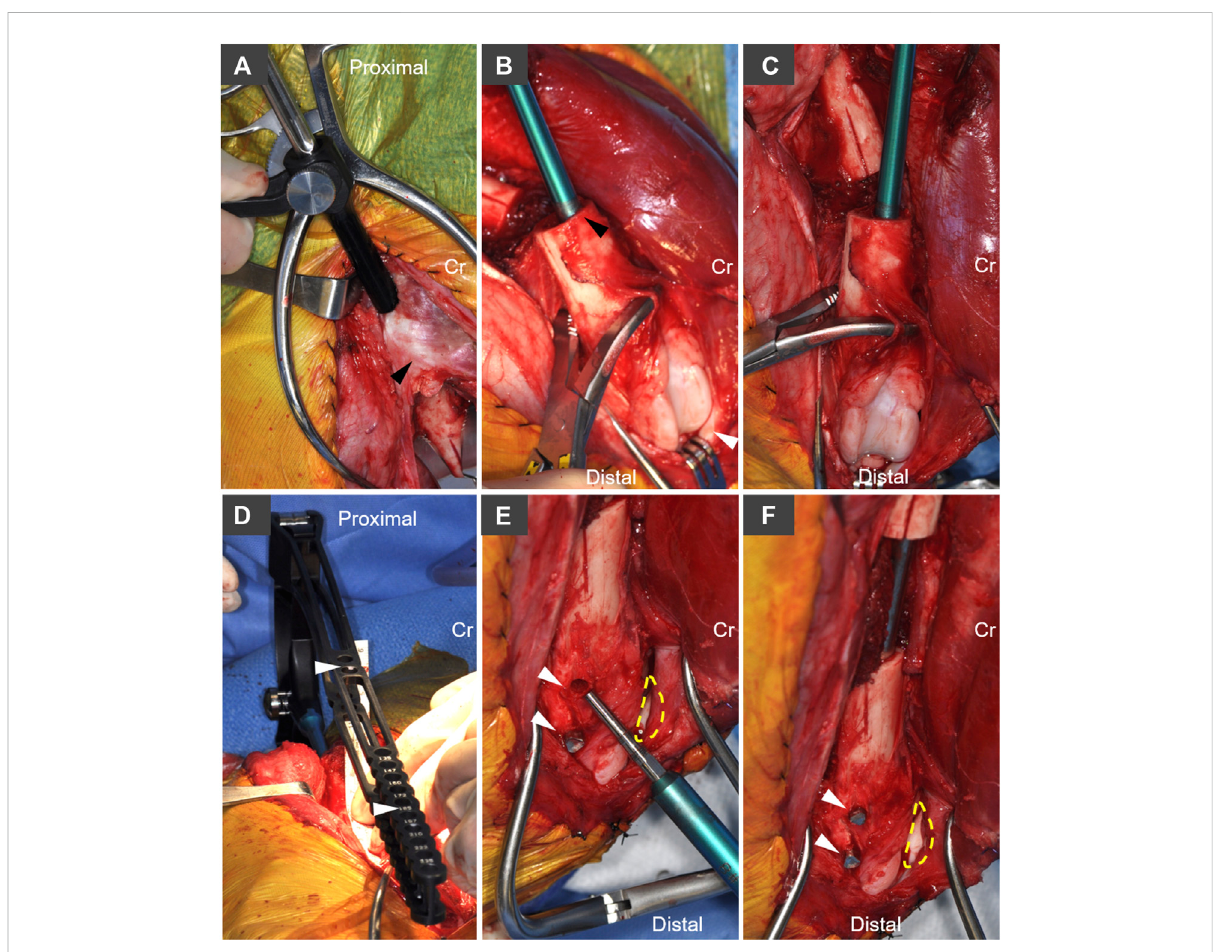
FIGURE 2 Implantation technique andsystem-speci fi cinstrumentationfortheAS-ILN. (A) Theintertrochanteric fossa wasidenti fi edandopened witha1/ 8 inch (3.2 mm) intramedullary pin. Following pin removal, a system-speci fi c cutting tool and tissue protector were used to enlarge this opening to 8 mm. Cr denotes cranial, arrowhead denotes base of the greater trochanter. (B) The distal femur was stabilized with bone holding forceps placed proximal to the trochlea. A system speci fi c cutting tool (8 mm diameter) was used to prepare the cancellous bone bed. To distalize the nail, the cutting tool was intentionally placed adjacent to the cranial (anterior) cortex in the lateral view (black arrowhead). White arrowhead denotes the patella. (C) From thecranial(anteriorview),carewastakento ensurethecutting tool wasoriented parallelto thelongaxisofthedistalfemur. (D) The 8 mm × 172 mm AS-ILN was attached to an extension and insertion handle and placed in normograde fashion into the femur. A system speci fi c alignmentguide(whitearrowheads),withcannulationsalignedtoAS-ILNcannulations,wasattachedtothehandleinordertocenterdrillingthrough the AS-ILN cannulations for capture by locking bolts. (E) Lateral aspect of distal femoral condyle demonstrating placement of angle-stable fi xation boltsindrillholescreatedusingthealignmentguideinpanel (D) .Dashedlinedenotespositionofpatella.Arrowheadsdenoteboltholes. (F) Finalbolt insertion (arrowheads) completes placement of the